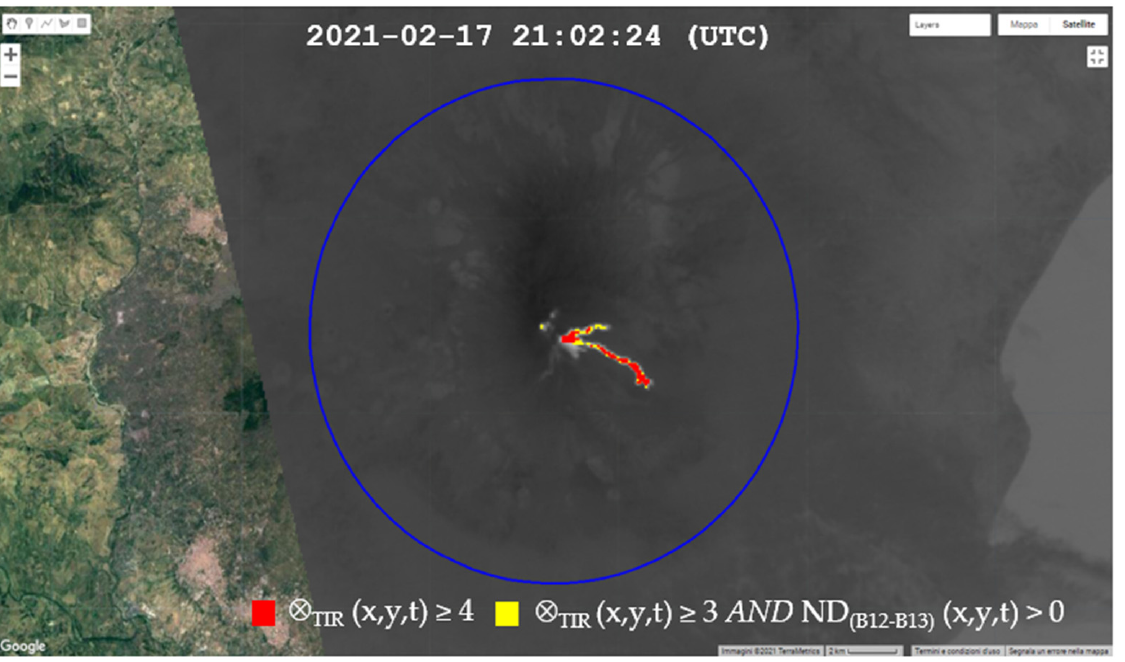
Figure 13. Thermal anomaly (red/yellow pixels) over Mt. Etna area detected by RASTer on 17 February